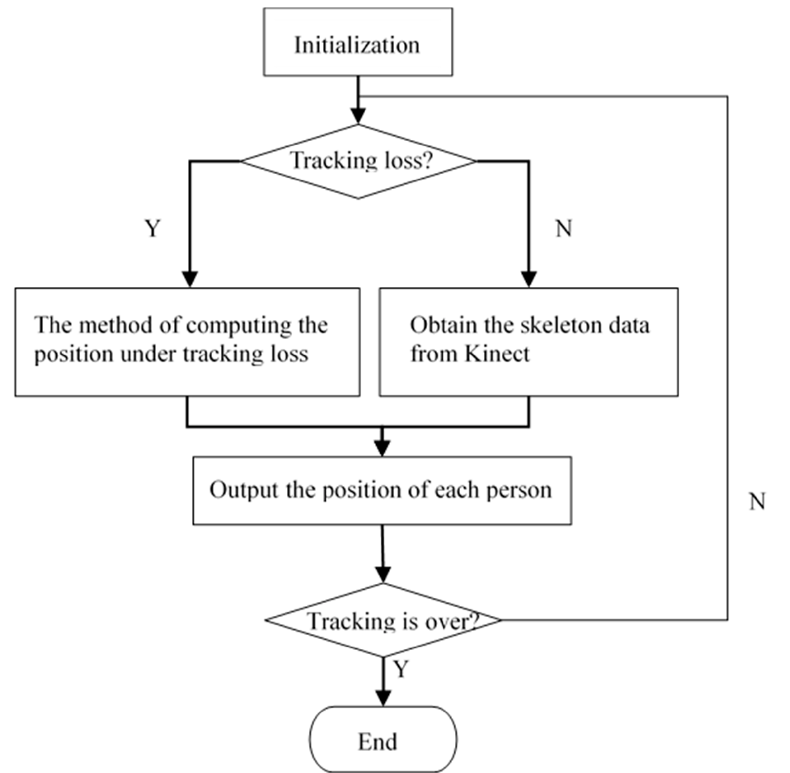
Figure 7. The flowchart of our proposed tracking method.